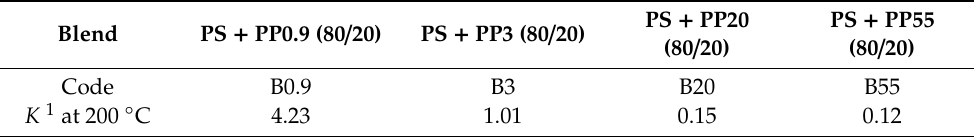
Table 2. Sample codes of prepared PS80 / PP20 blends with di ff erent viscosity ratio K = ( η 0,PP / η 0,PS ) . Blend PS + PP0.9 (80 /